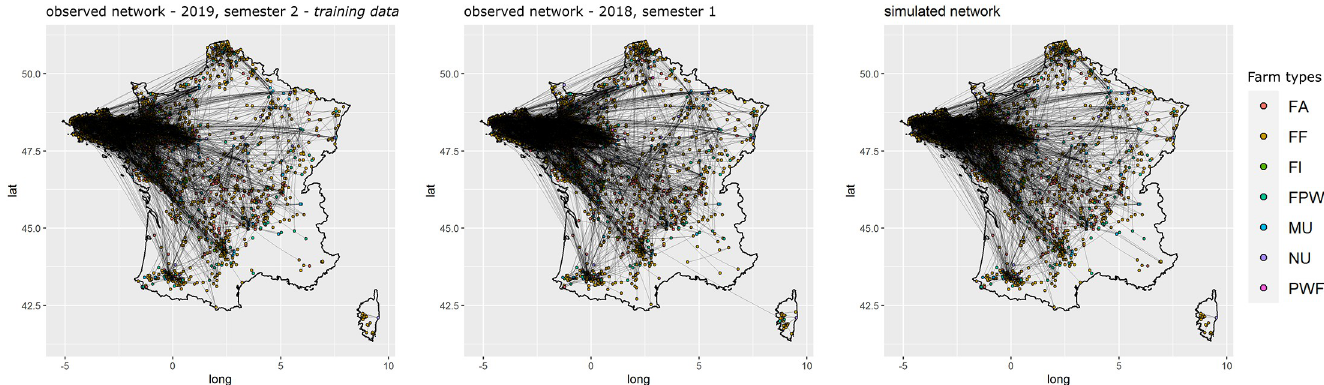
Fig 8. Maps of observed and simulated networks for sows. Mapping of semestrial networks drawn by the transport of sows. The network on the left was observed during the second semester of 2019, those data were used to fit the model, the network in the center was observed during the first semester of 2018, and the one on the right was simulated using the fitted exponential random graph model.